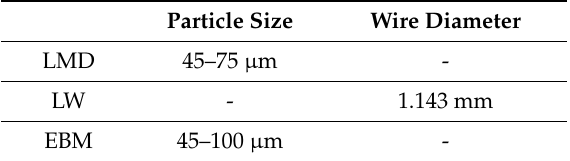
Table 6. Powder particle size and wire diameter of the AM raw